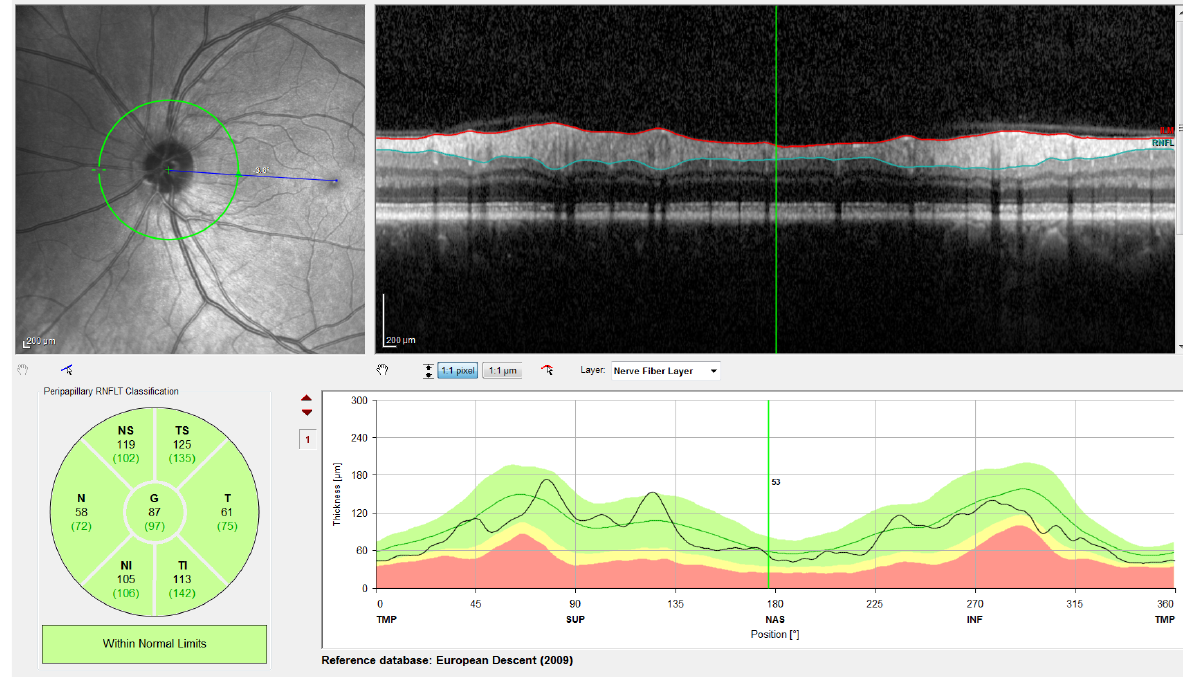
Figure 2. Screenshot provided by the Spectralis software version 6.9.4.0. From left to right and top to bottom: Retinal fundus photography centered on the optic disc (the yellow circle indicates the location of the peripapillary B-scan, which is shown on the right with the segmentation of the RNFL); 2D peripapillary B-scan OCT on Cartesian coordinates; estimated mean values for RNFL layer thickness for the temporal (T), temporal superior (TS), nasal superior (NS), nasal (N), nasal inferior (NI), and temporal inferior (TI) sectors, as well as the overall mean (G); rectified outline of the RNFL with estimated thickness and reference values according to the database European Descent